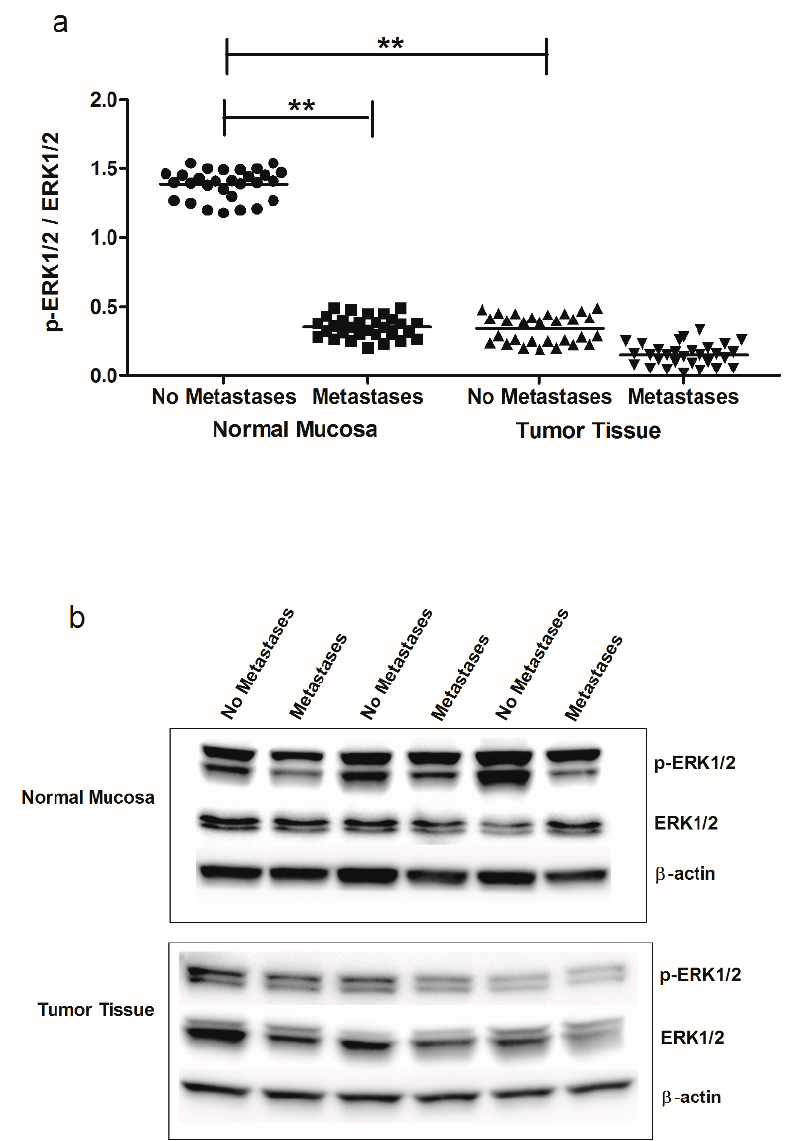
patients without metastases. ( b ) Dot plots graph of p-p38 MAPK/p38 α MAPK ratio protein values detected in our patients groups. ** p < 0.02, *** p < 0.001 indicate statistically significant differences (one-way analysis of variance with Dunnett’s and Tukey’s multiple comparison test, where appropriate). ( c ) Representative Western blot bands of p-p38, p38 α and β -actin proteins.